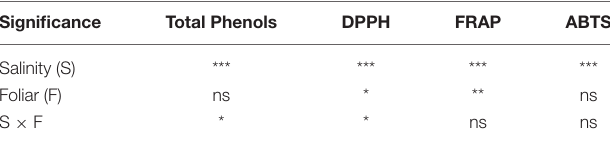
TABLE 4 | Effect of salinity levels (0–25–50–100mM NaCl) and foliar applications (no foliar, K, Zn, and Si) on the content of total phenols and antioxidant activity in lavender grown hydroponically in perlite.